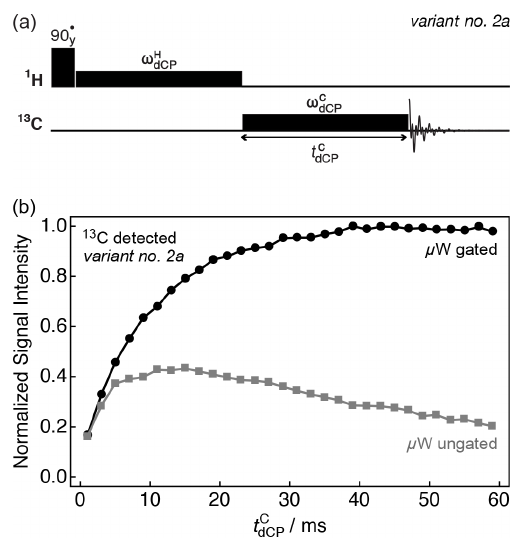
Figure 3. (a) Simplified schematic representation of variant no. 2a of the d CP rf-pulse sequence. (b) Experimental 13 C NMR signal intensity of I as a function of the d CP rf-pulse duration t C quired at 7.05T ( 1 H nuclear Larmor frequency = 300 . 13MHz; 13 C nuclear Larmor frequency = 75 . 47MHz) and 1.2K with a single transient per data point.